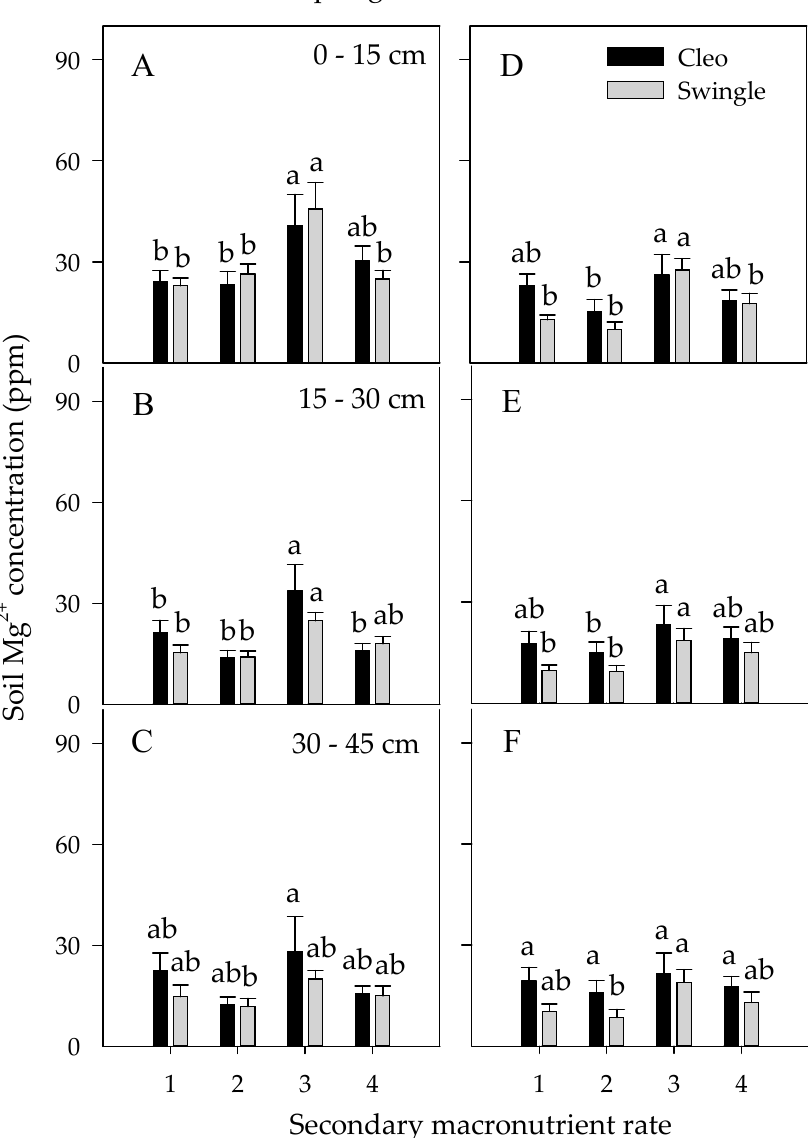
Figure 8. Soil Mg 2+ dynamics and accumulation of Huanglongbing (HLB)-affected Hamlin citrus trees budded on Cleo and Swc rootstocks during spring ( A – C ) and summer ( D – F ) 2018 in three soil depths (0–15, 15–30, and 30–45 cm). Treatments: Control (1), full Ca dose (2), full Mg dose (3), and half Ca and half Mg doses (4), (full dose = 45 kg ha − 1 ). Means with different lower case letters are significantly different at p ≤ 0.05, based on the Tukey–Kramer honestly significant difference test (n = 36).